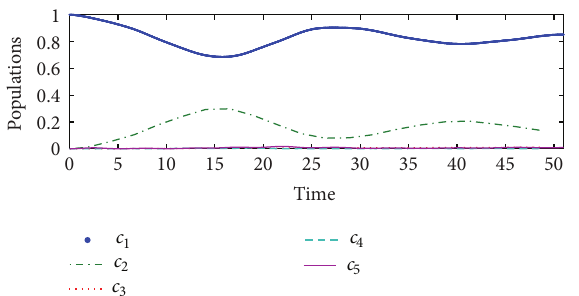
Figure 3: The population of the system state by the hybrid impulsive control based on the state error.